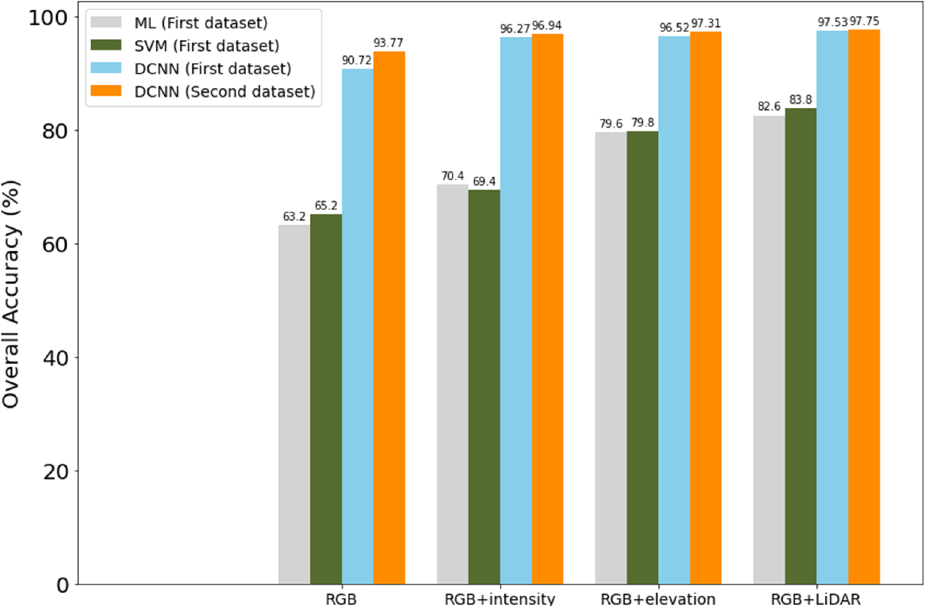
Figure 25. Overall accuracy comparison between the ML and the DCNN.